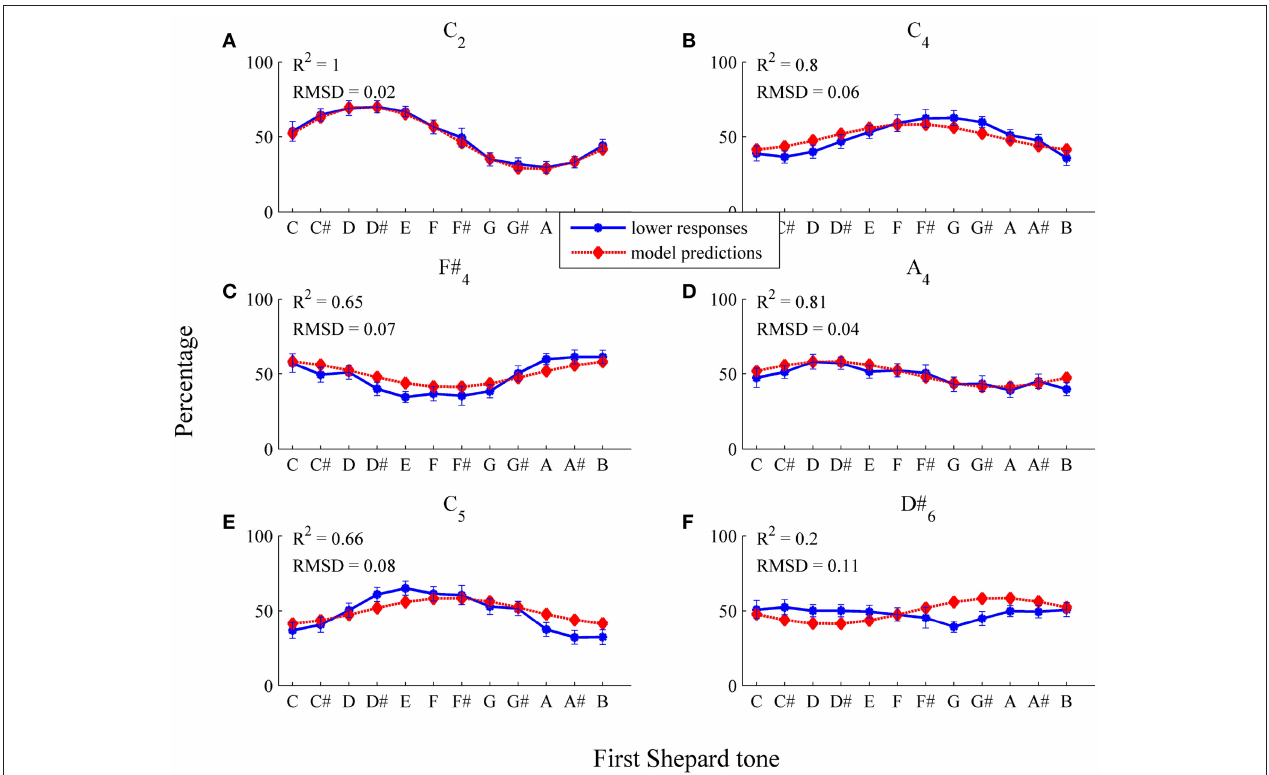
FIGURE 9 | Fitting the logistic threshold function: average percentages of lower responses (blue dots and unbroken line) in comparison to model predictions for the six envelopes (A) C 2 , (B) C 4 , (C) F # 4 , (D) A 4 , (E) C 5 , (F) D # 6 (red diamonds and dotted line; estimated model parameters: σ 2 0.18 ). The error bars represent the standard error of mean ( n ˆ =